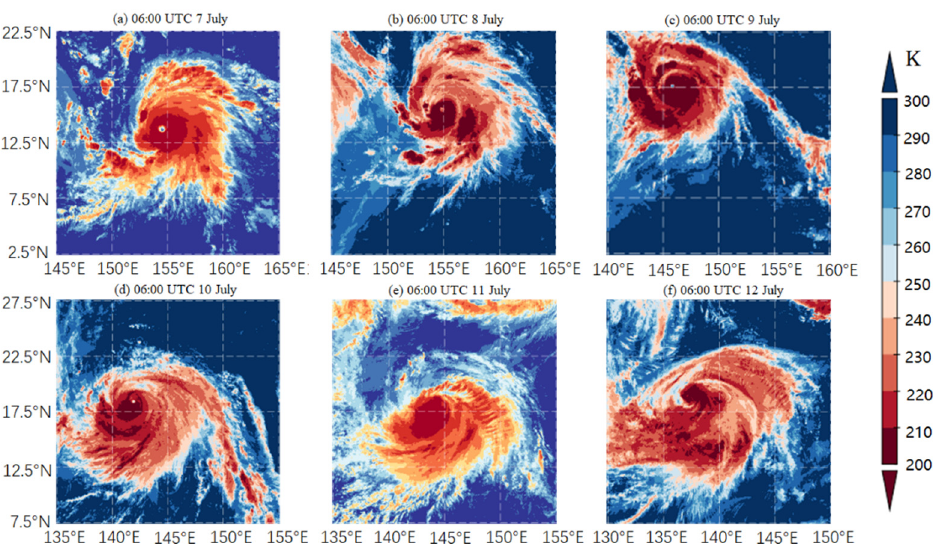
Figure 2. The black body temperature at the 11.2 µ m band of the Himawari-8 satellite with 24 h interval from 7 to 12 July 2015 (unit: K).